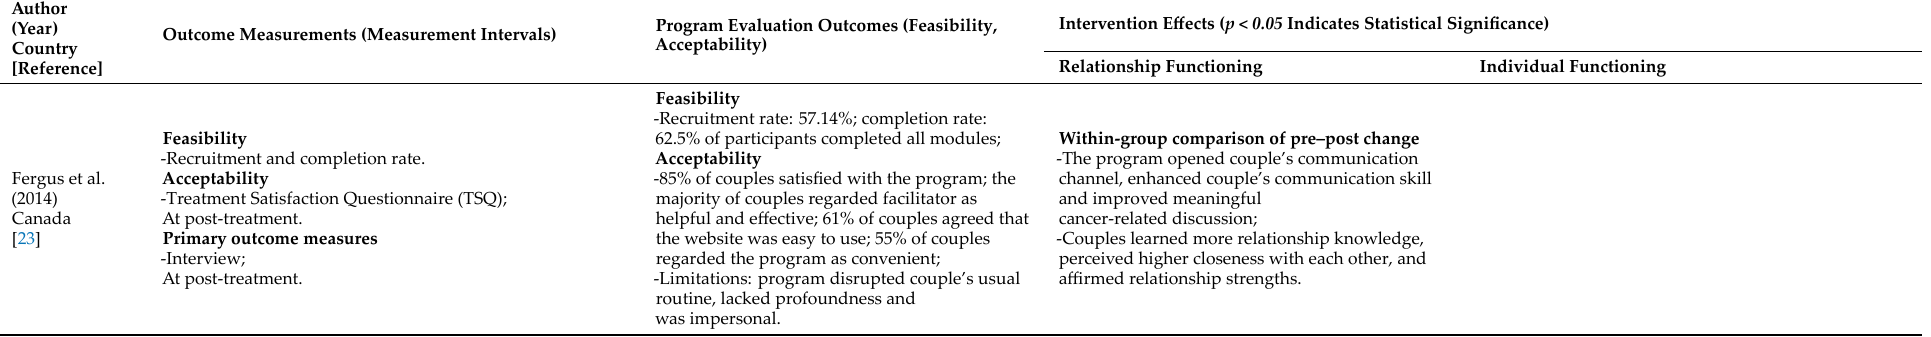
Table 2. Outcomes of included studies. Symbols # and * could help us to distinguish whether the tools examine patients or spousal caregivers